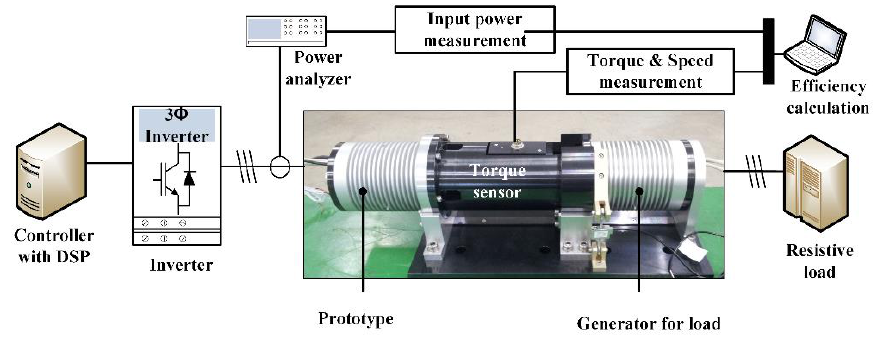
Figure 3. Performance evaluation system.